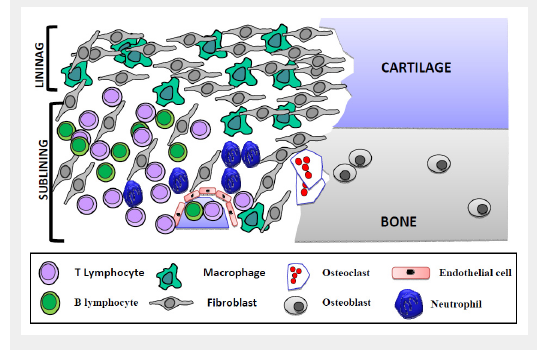
Figure 1 Representation of the different cell types in the rheumatoid